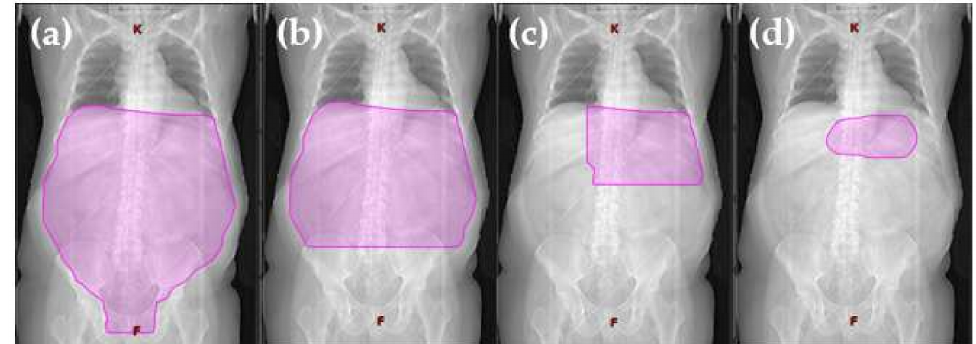
Figure 1. Visualization of radiation volume decrease from extended field to involved site radiotherapy.